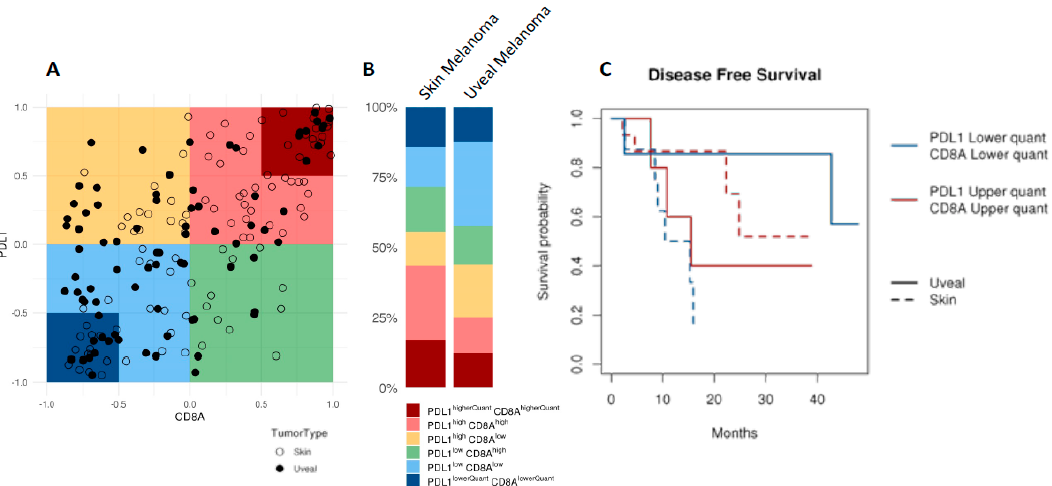
Figure 4. Comparison of immunogenicity between UM and cutaneous melanoma; Data extracted from the TCGA database. ( A , B ) Less than 25% of UM tumours express high CD8A and PDL1, whereas close to 50% of cutaneous melanoma tumour samples express high levels of both genes. ( C ) Kaplan–Meier PFS curves of UM and cutaneous melanoma with the highest (red) and lowest (blue) quartile of expression of both CD8A and PDL1. Highly immunogenic tumours seem to have better prognosis in cutaneous melanoma, although the opposite effect is seen in UM, even showing that all patients in the CD8A high /PDL1 high -quartile experience disease relapse.